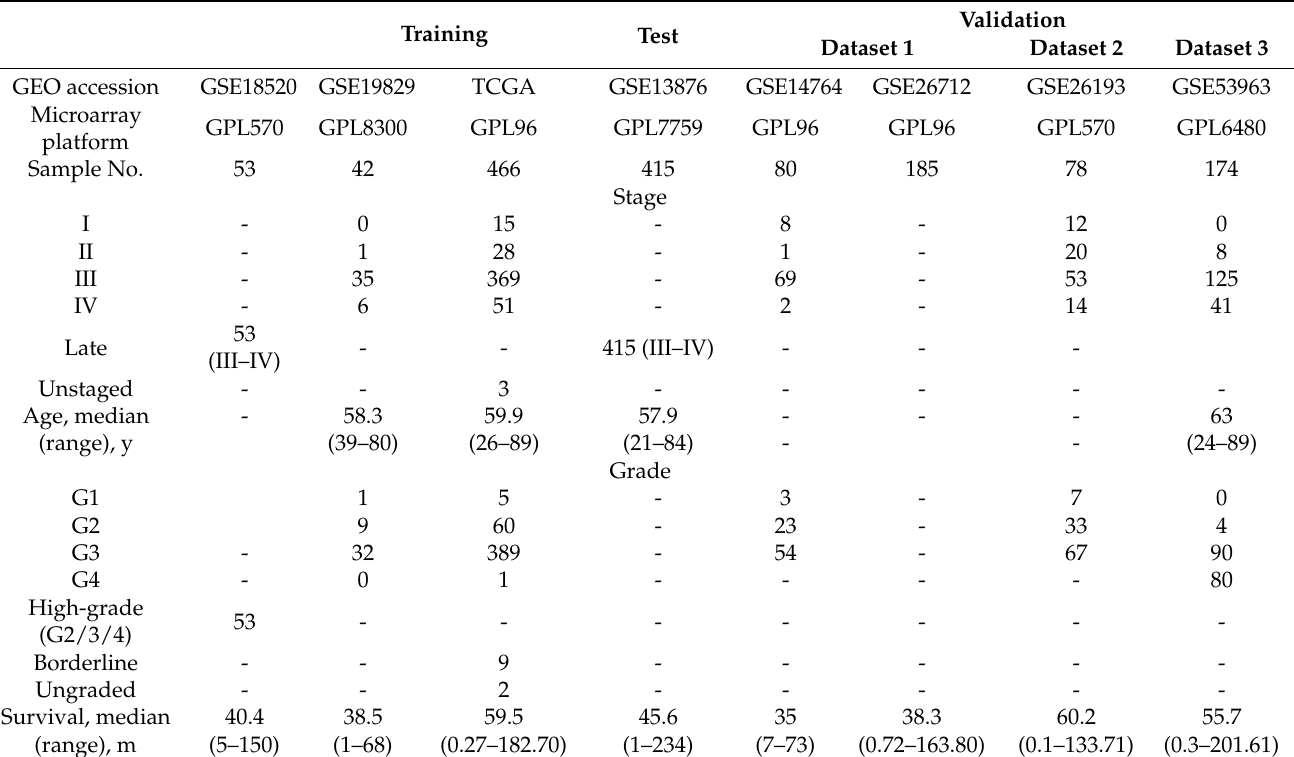
Table 1. Clinical characteristics of serous ovarian cancer samples used in this